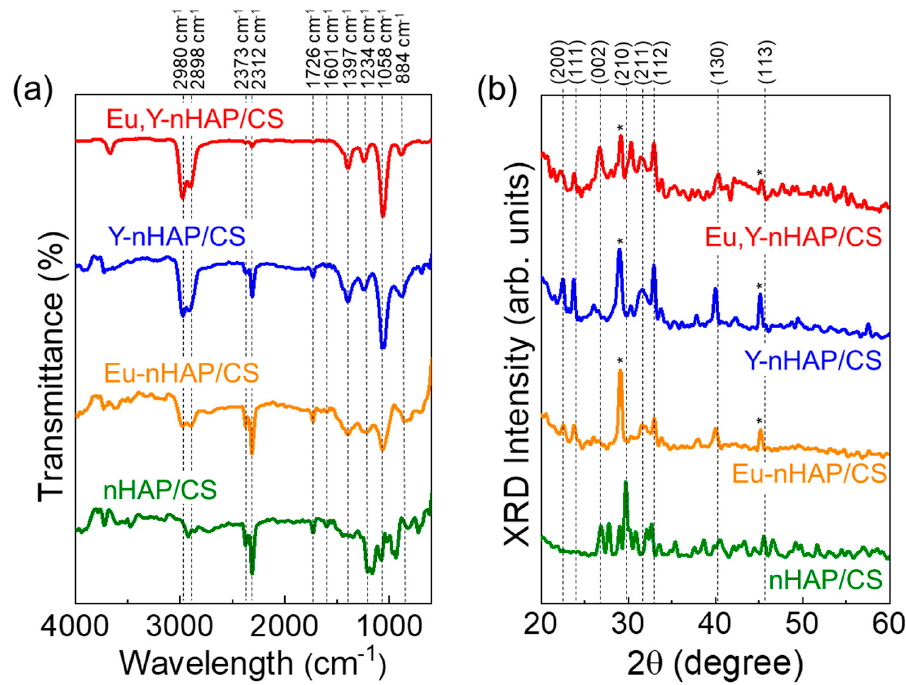
Figure 1. ( a ) FTIR spectra and ( b ) XRD patterns of the nHAP/CS, Eu-nHAP/CS, Y-nHAP/CS, and Eu,Y-nHAP/CS biocomposites. Eu,Y-nHAP/CS